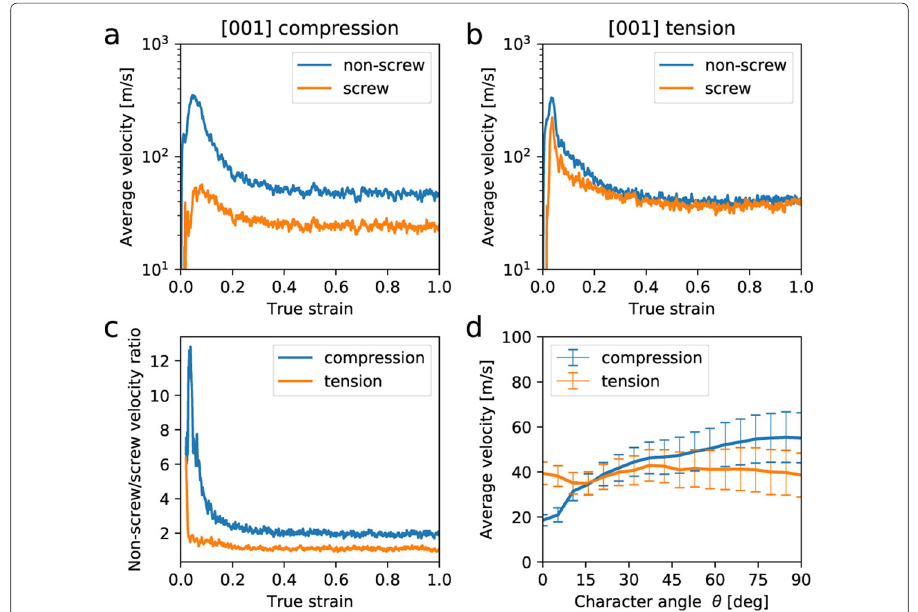
Fig. 7 Average velocities ˜ v of screw and non-screw dislocation populations extracted from STA facets computed under uniaxial a compression and b tension. c Ratio of average velocity of non-screw dislocations to average velocity of screw dislocations as a function of strain. d Dislocation velocities averaged over strain interval from 0.5 to 1.0 broken down dislocation character